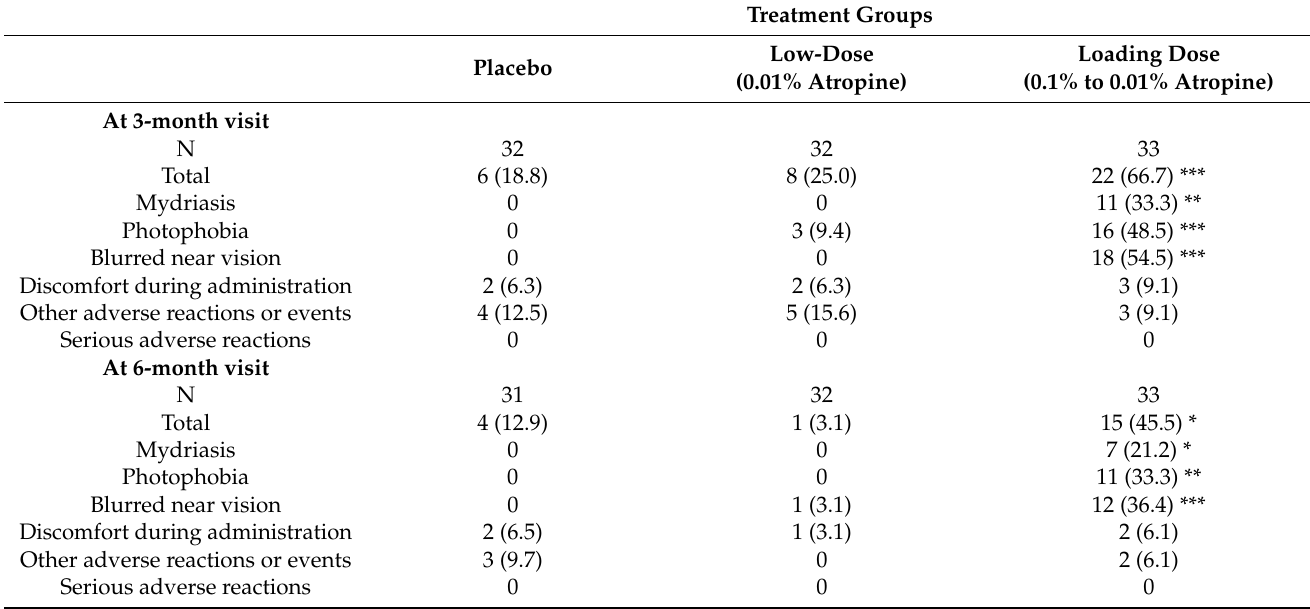
Table 3. Adverse reactions and